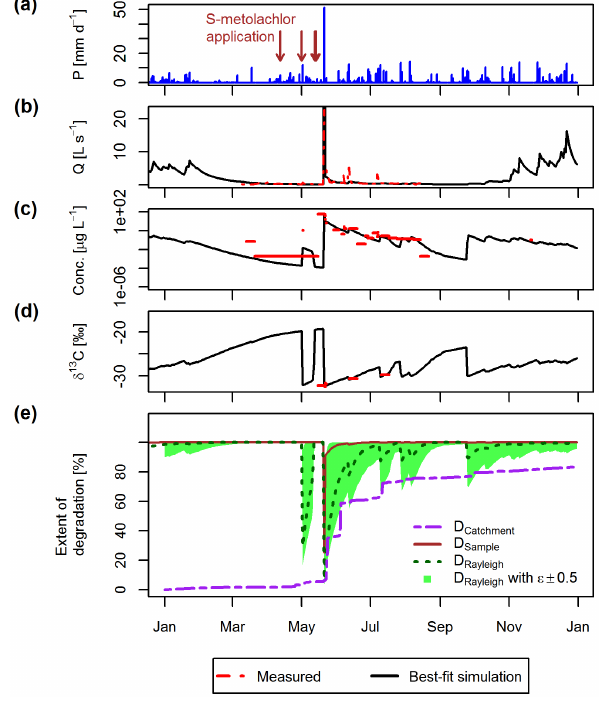
Figure 7. Measured (red lines) and modelled time series (black lines; best-fit simulation) for discharge (b) , S-metolachlor concen- trations ( c ; note the log-scaling), and δ 13 C values (d) , as well as the extent of degradation as obtained by the Rayleigh equa- tion ( D Rayleigh , dotted green line; range of D Rayleigh for ε C = − 1 . 13 ± 0 . 5‰, green area) and as known from the model for the sample ( D Sample , solid brown line) and for the entire catchment ( D Catchment , dashed purple line; e ). Blue bars in (a) indicate daily precipitation and brown arrows indicate the dates of pesticide appli-